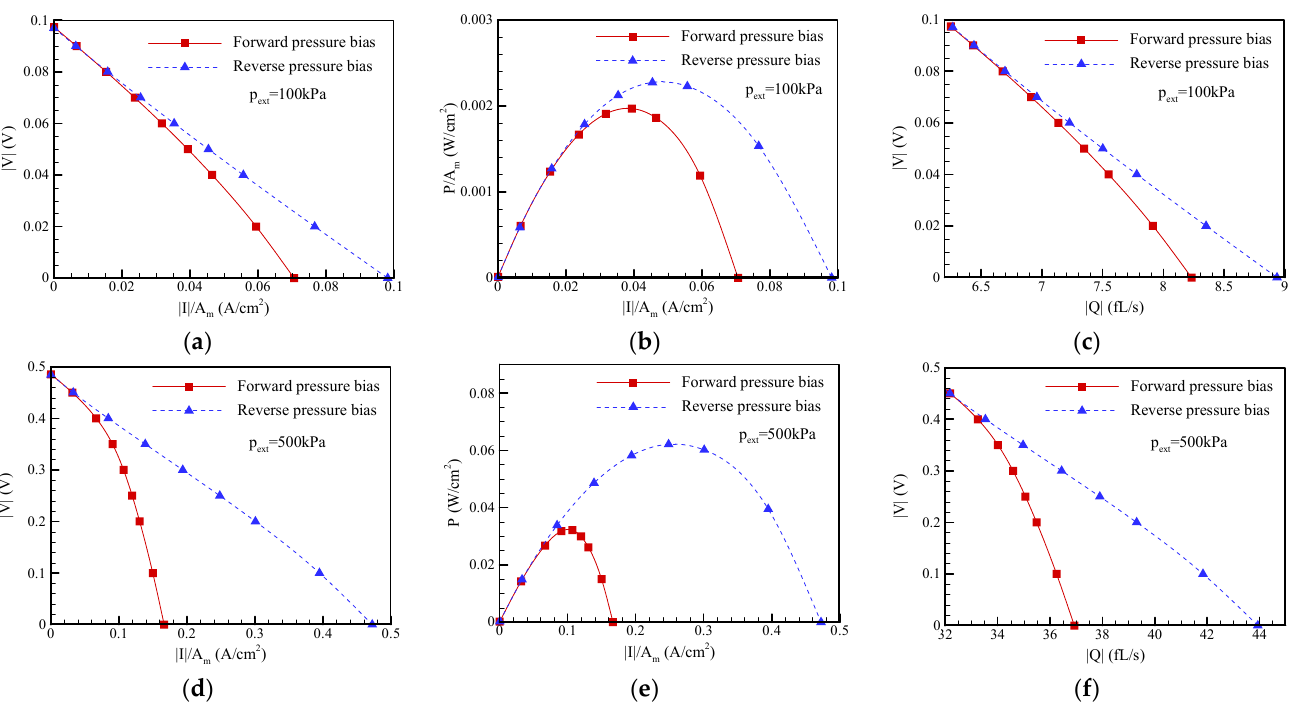
Figure 8. Plots of the I-V curve, I-P curve, and Q-V curve for EKEC in a conical nanopore at a salt concentration of c 0 = 0.1 mM under different pressure biases: ( a – c ) p ext = 100 kPa; ( d – f ) p ext = 500 kPa. Note that θ = 1.2°, σ s = −5 mC/m 2 , and b = 20 nm. A = π (a ) 2 , where a is the radius at the middle of the conical nanopore.